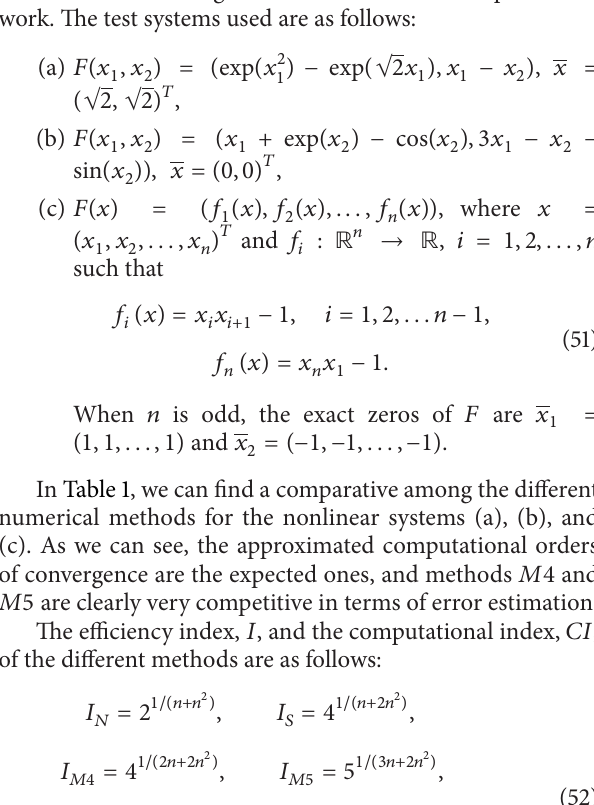
Figure 3: Comparative among the computational indices of the